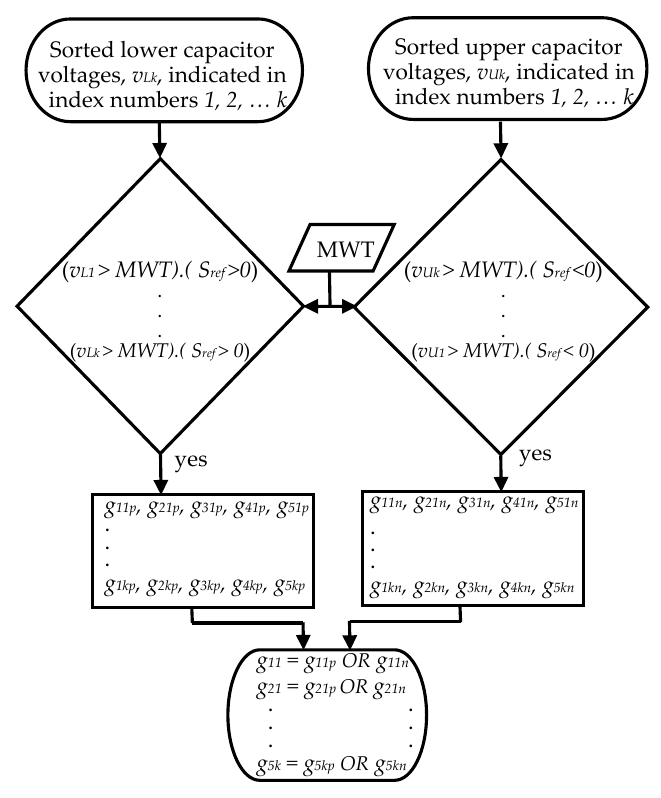
Figure 5. Switching signal generation. Positive and negative half cycles of the reference signal, S ref are considered in the in- put capacitor voltage balancing. The upper and lower capacitor voltages in each cell are